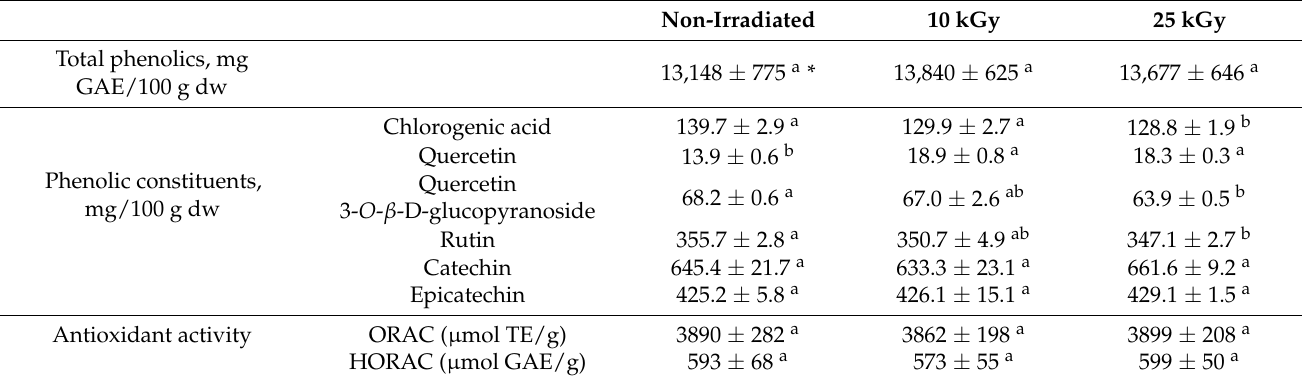
Table 3. Phenolic constituents and in vitro antioxidant activity of non-irradiated, 10 kGy-, and 25 kGy-irradiated RH fruits.